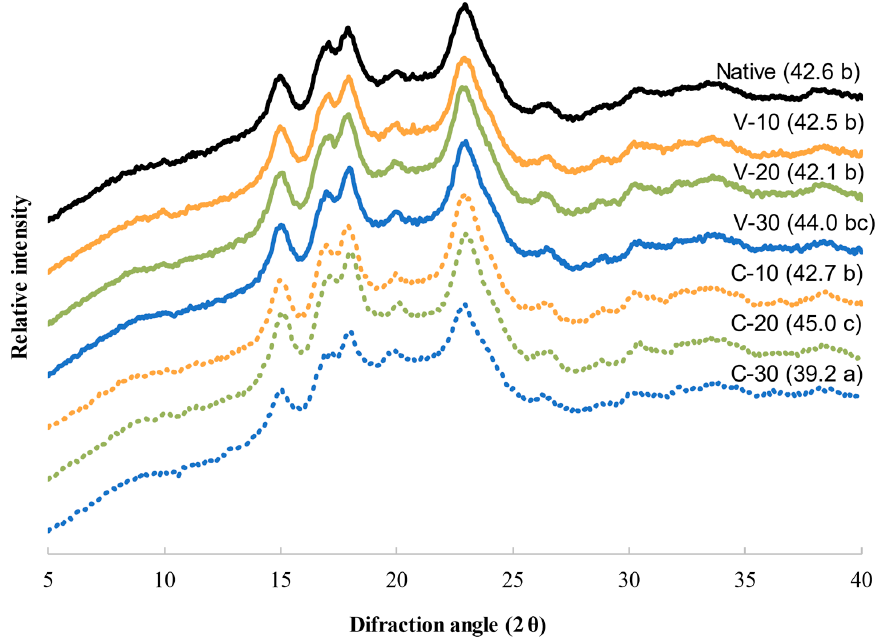
Figure 4. X-ray diffraction patterns (XRD) of untreated flour (native) and flours obtained from microwaved grains with 10, 20, and 30% water content with treatment systems of variable (V) and constant (C) water content. The percentage of crystallinity of each sample is shown in brackets. Mean values with different letters for the same parameter imply significant differences between means at p < 0.05.